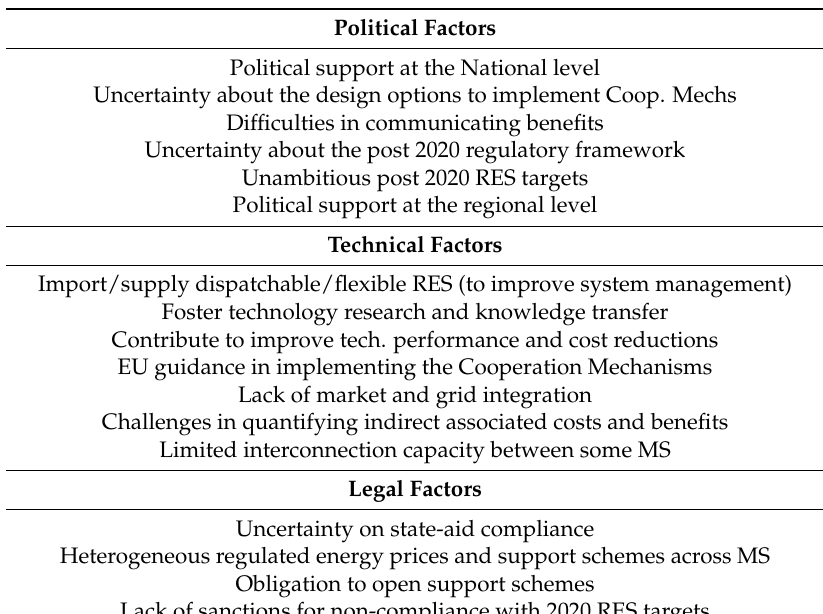
Table 2. Categorization of